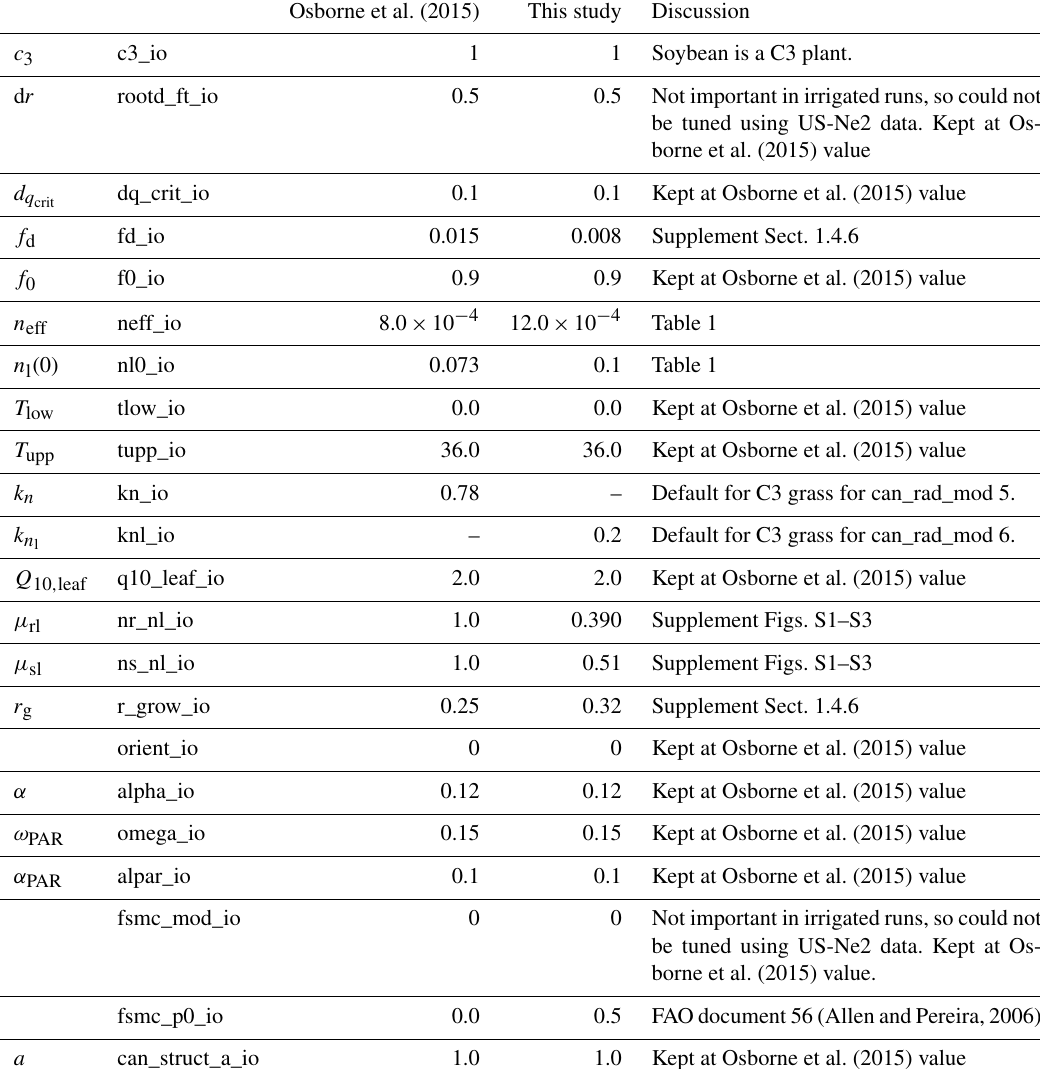
Table 3. JULES plant functional type parameters extended to represent